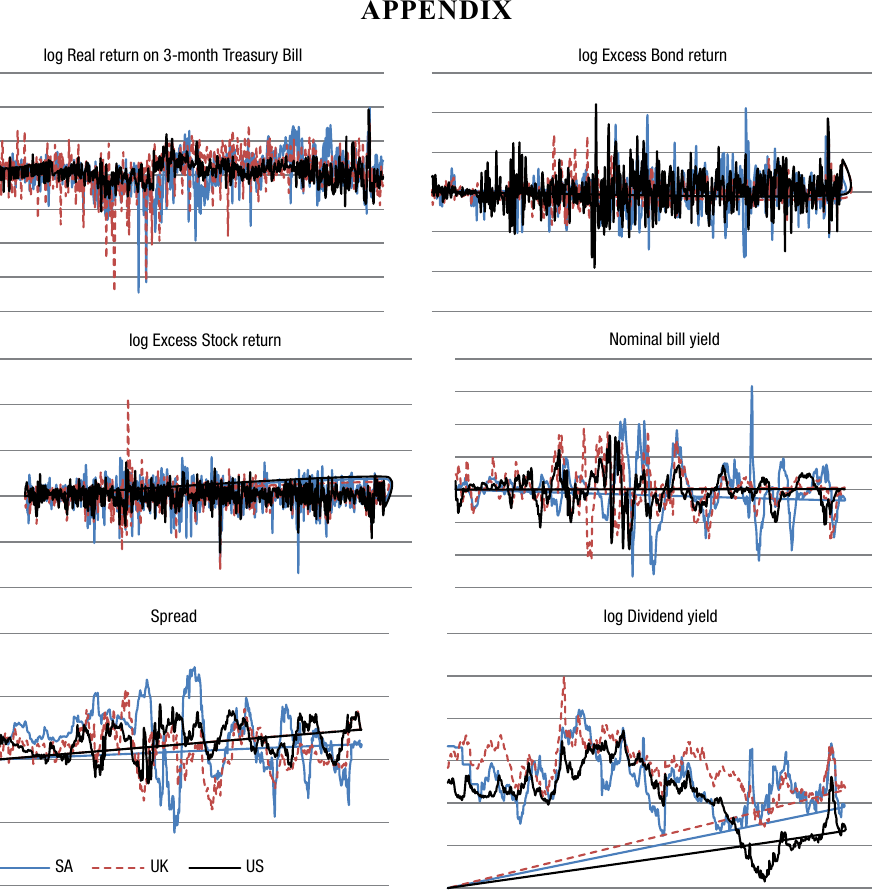
Fig. A. Variables included in the vector of state